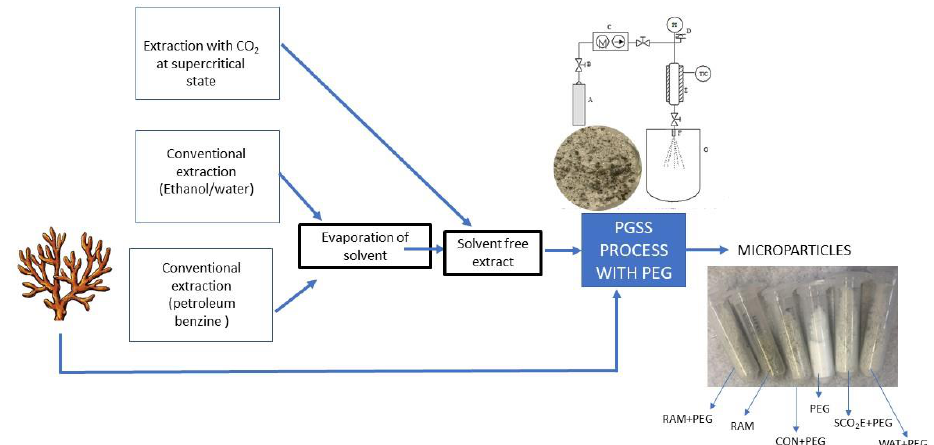
Figure 1. Schematic overview of used procedure and methods (RAM+PEG — raw algal material, SCO 2 E+PEG — extract obtained with supercritical extraction, CON+PEG — dry extract obtained with conventional extraction, WAT+PEG — dry extract obtained with ethanol/water extraction, PEG — polyethylene glycol, RAM . — raw algal material.